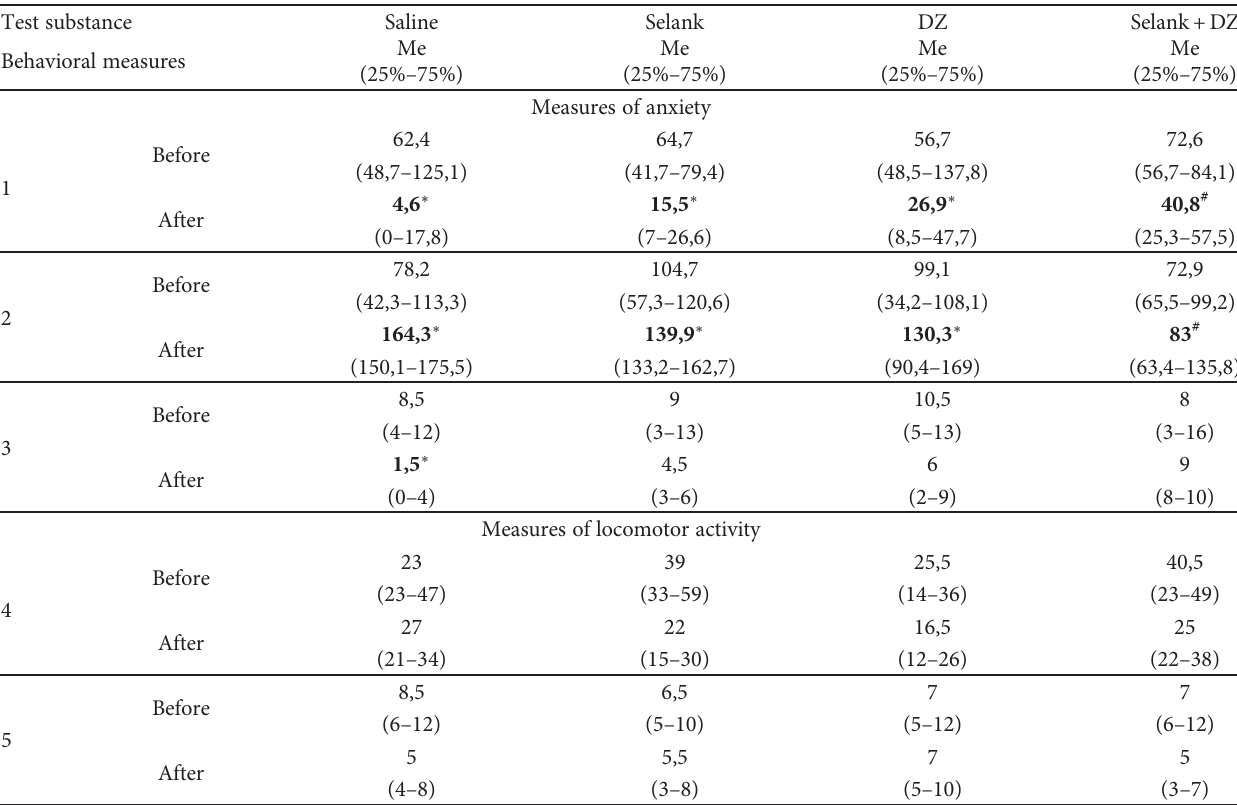
Table 3: Indicators of the behavior of rats that were exposed to unpredictable chronic stress at the EPM test before and after exposure to stress and the administration of a course of the test substances. 1, time spent in the open arms of the maze, s; 2, time spent in the closed arms of the maze, s; 3, number of hanging events from the open arms; 4, number of squares crossed; 5, number of